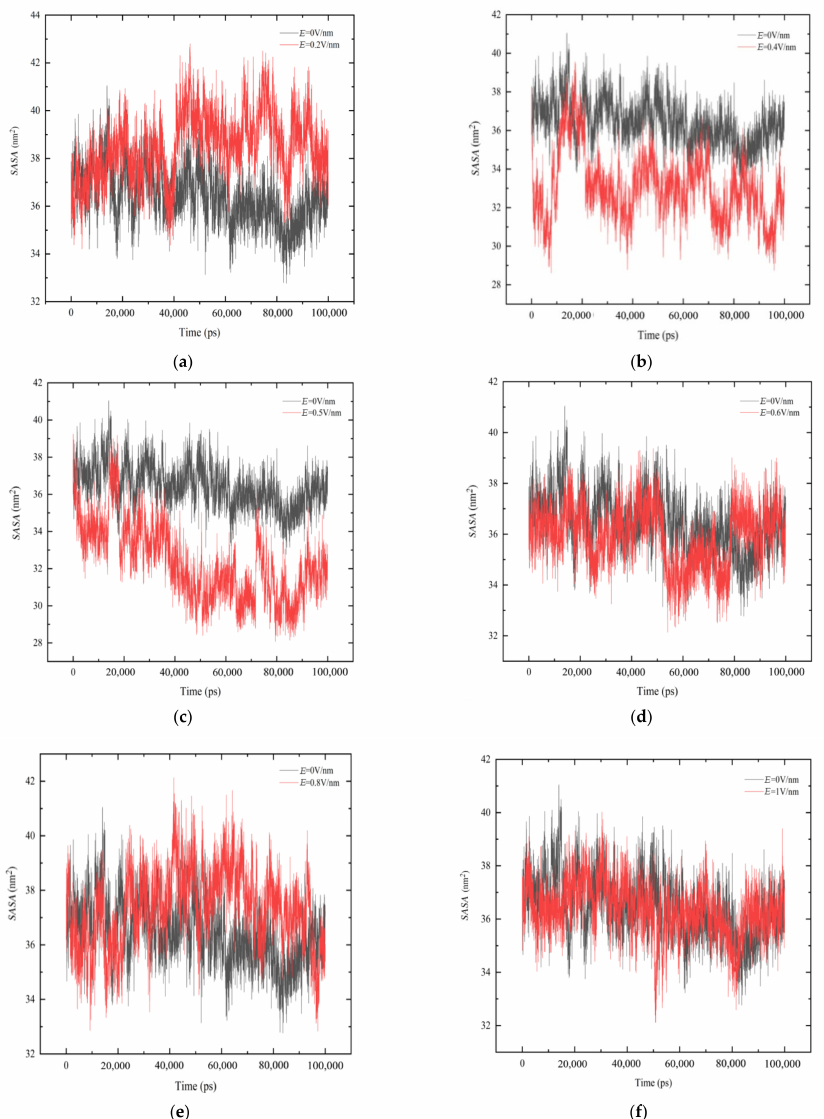
Figure 7. Changing in solvent accessible surface area ( SASA ) is shown as a function of time in 100 ns under different electric field strength. ( a ) E = 0.2 V/nm, ( b ) E = 0.4 V/nm, ( c ) E = 0.5 V/nm, ( d ) E = 0.6 V/nm, ( e ) E = 0.8 V/nm, ( f ) E = 1